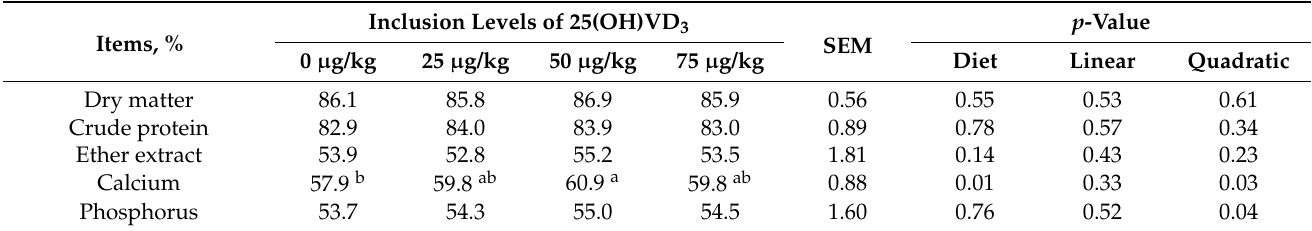
Table 3. Effects of 25(OH)VD3 inclusion doses on nutrient digestibility of growing-finishing